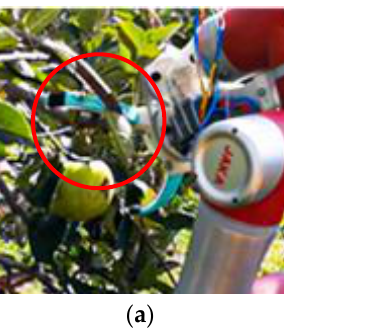
Figure 2. Cases of picking failure because the fruit growth orientation has not been considered: ( a ) the gripper cannot grasp the fruit because of interference from a branch; ( b ) fruit and branches are gripped at the same time.